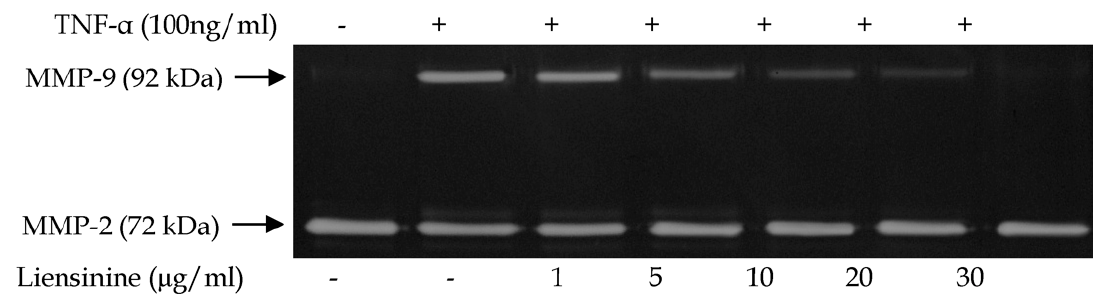
togen/activator that stimulates MMP-9 enzyme activity in VSMCs [28]. The effect of liensinine on the MMP-9 proteolytic degradation of gelatin in VSMCs is displayed in Figure 4. The MMP-9 band was drastically increased by TNF- α (compared to without TNF- α ) and decreased concentration dependently by liensinine (compared to TNF- α ).